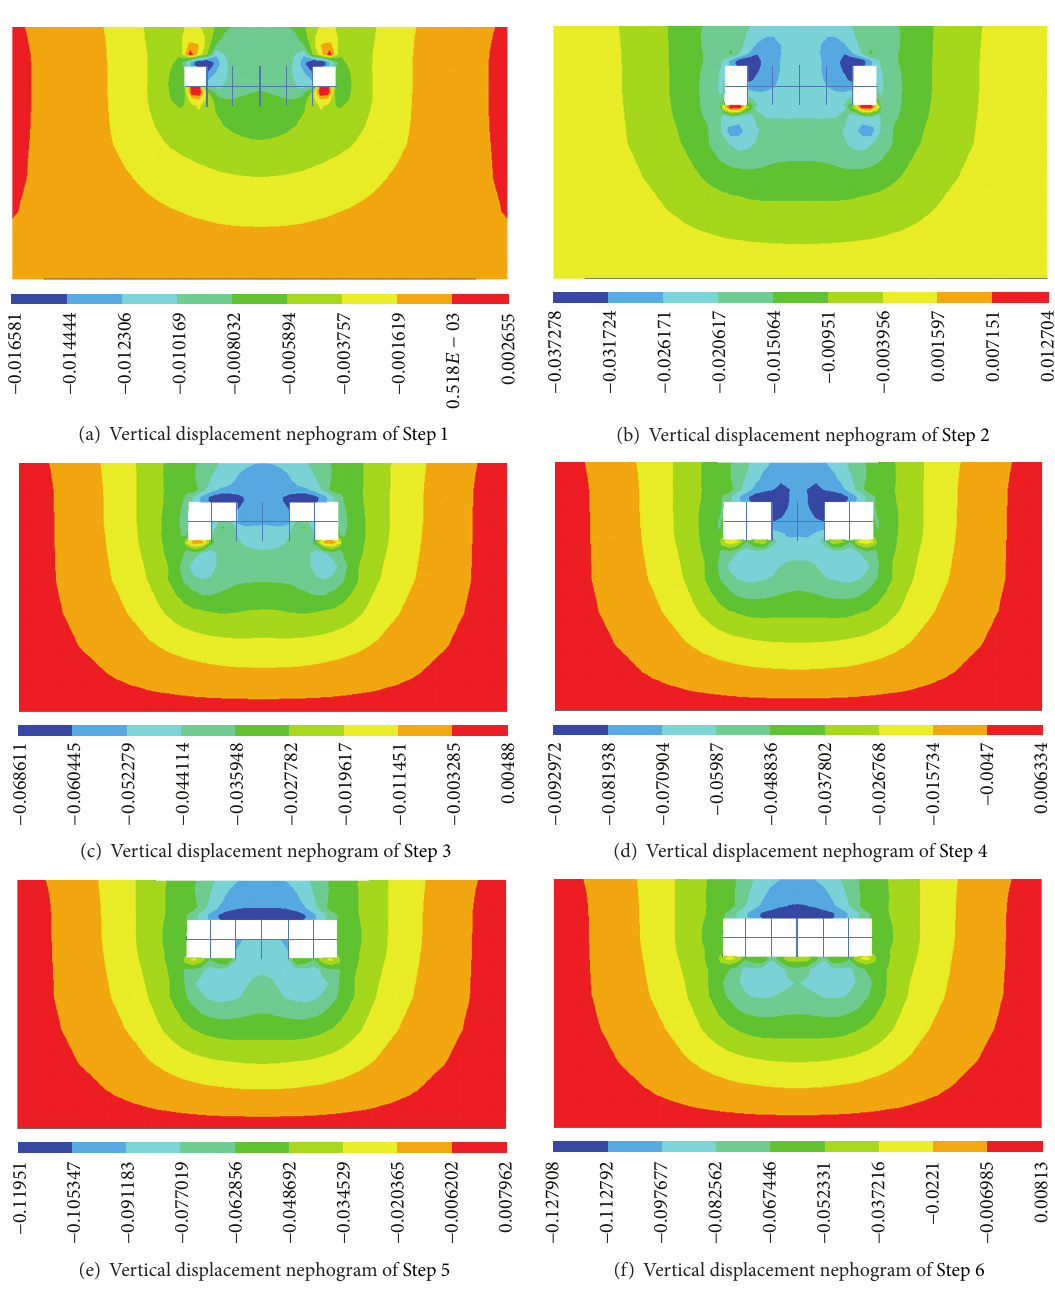
Figure 8: Vertical displacement nephograms of each